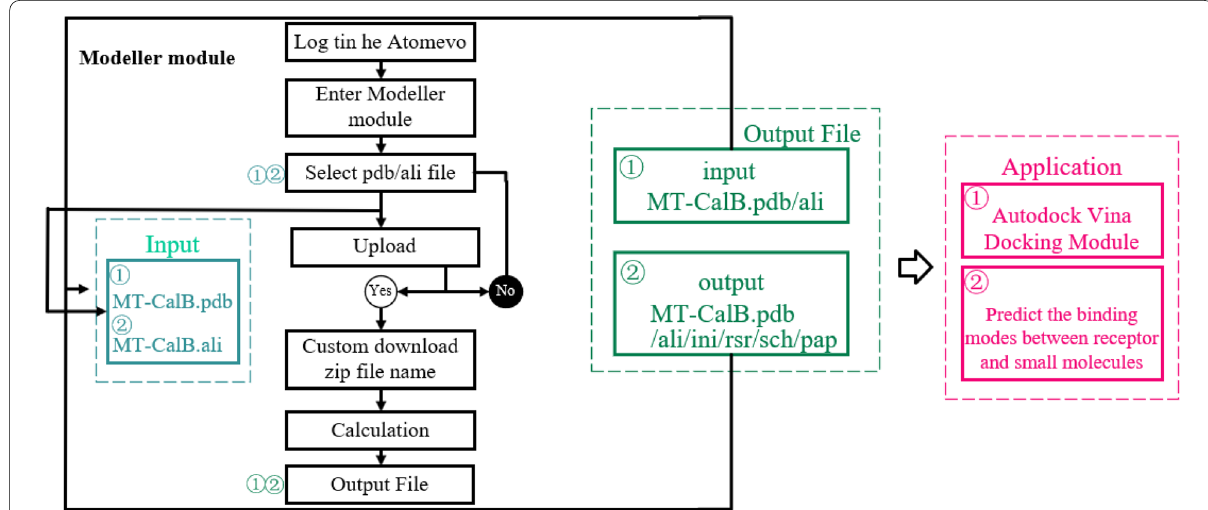
Fig. 1 Flow diagram of modeller